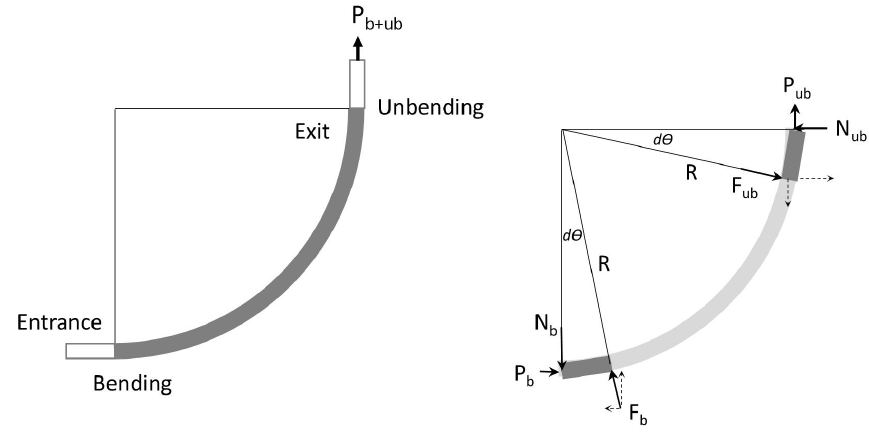
Figure 10. Force diagram at the die entrance point and exit point.